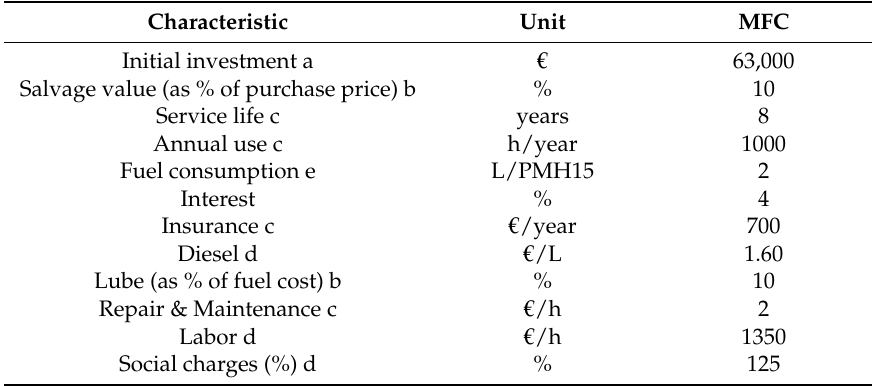
Table 1. Costing: assumptions, cost items and